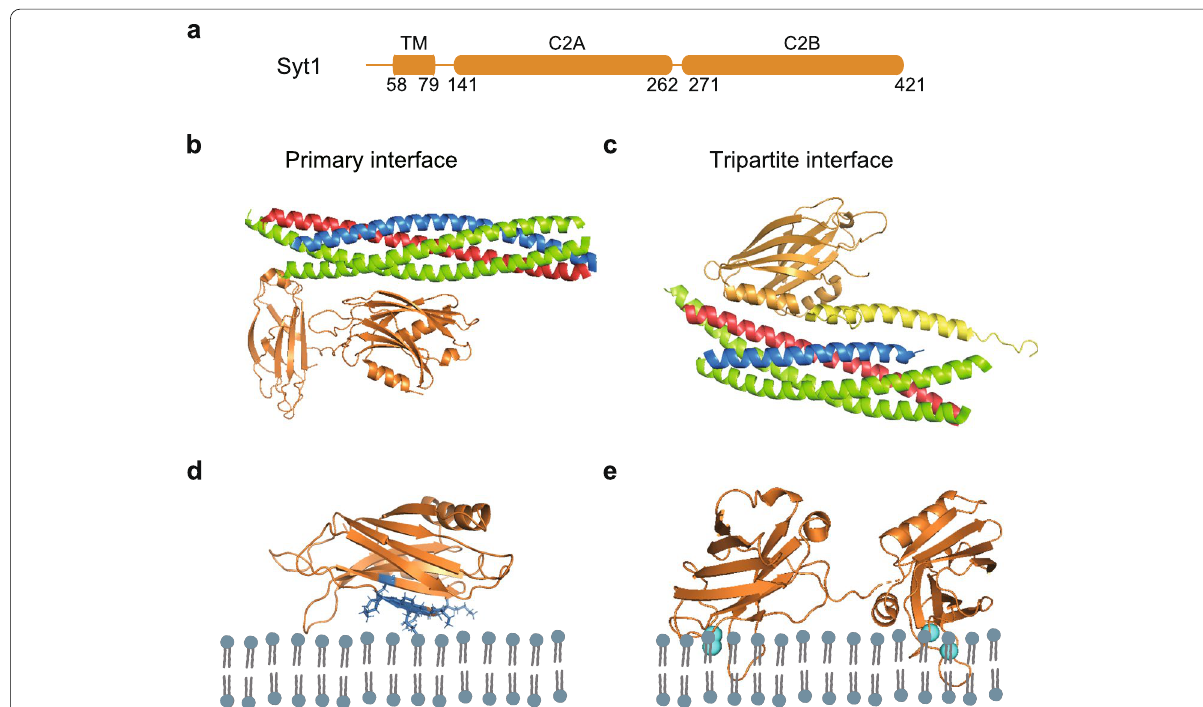
Fig. 4 Syt1 and its interactions with SNARE complex and membrane. a Domain diagram of Syt1. Residue numbers are indicated below the diagram. b Crystal structure of the primary interface of SNARE-Syt1 complex in Rattus norvegicus (PDB ID: 5CCI) [240]. c Crystal structure of the tripartite interface of SNARE-Syt1-Cpx1 complex in Rattus norvegicus (PDB ID: 5W5D) [241]. d Model of polybasic region of C2B domain interacting with the anionic membrane (PDB ID: 1K5W) [242]. The side chains of the residues in the polybasic region (K313, K321, R322, K324, K326, K325 and K327) are shown in blue sticks. e Crystal structure of the tandem Syt1 C2AB (orange) domains in Rattus norvegicus (PDB ID: 5KJ7) [239] in the presence of Ca 2 + (cyan